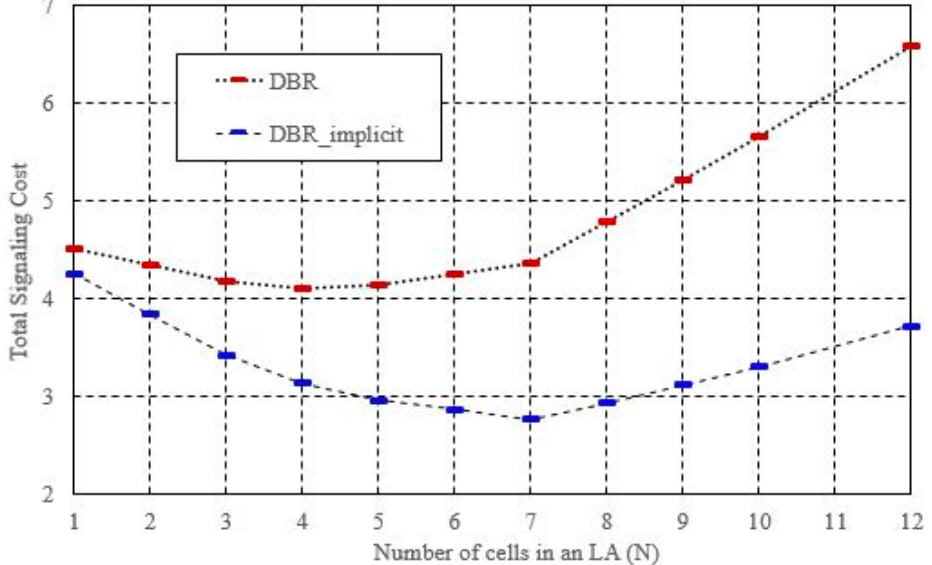
Figure 14. Total signaling cost for various numbers of cells in an LA (CMR = 1).